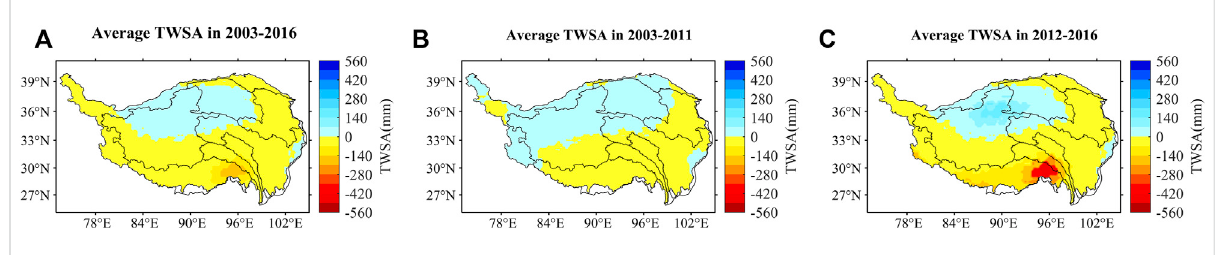
FIGURE 5 ThespatialpatternofaverageannualTWSAintheTibetanPlateau. (A) isaveragedTWSAin2003 – 2016, (B) isaveragedTWSAin2003 – 2011,and (C) is averaged TWSA in 2012 –